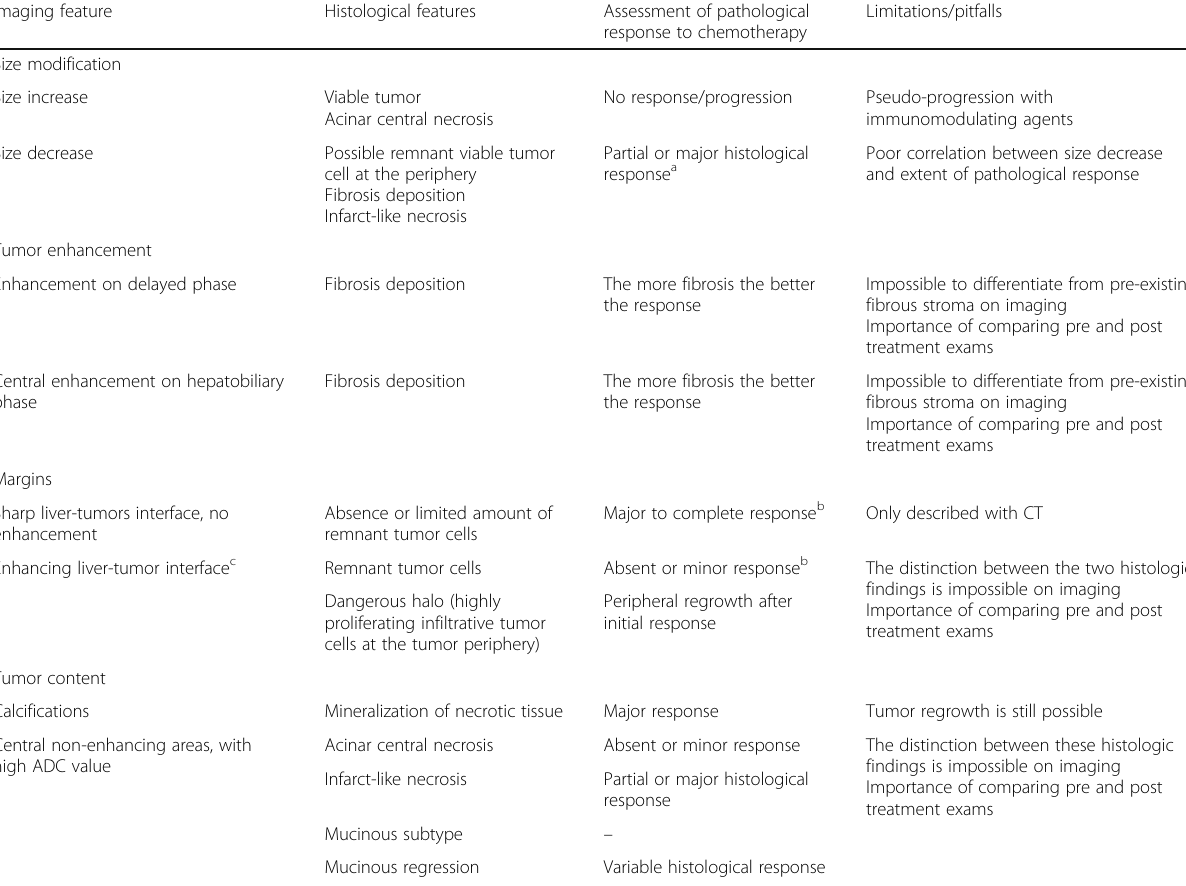
Table 2 Radiopathological signification of the main imaging features of colorectal liver metastases treated by systemic therapies